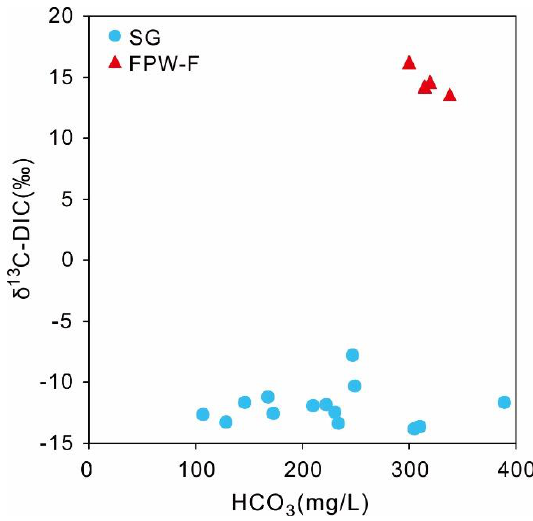
Figure 5. The diagram of δ 13 C-DIC vs. HCO 3 for shallow groundwater and FPW-F. Compared with the depleted δ 13 C-DIC of groundwater, the FPW from Fuling gas field had